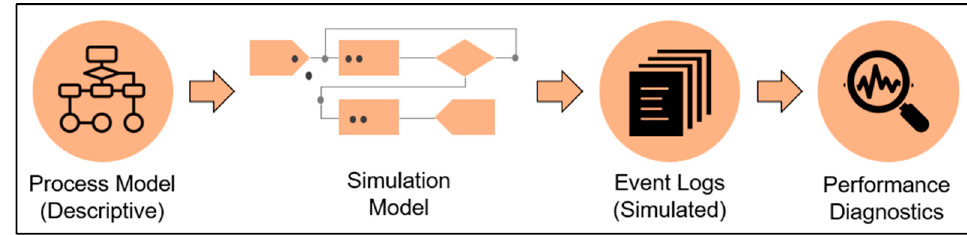
Figure 1. The classical use of simulation.